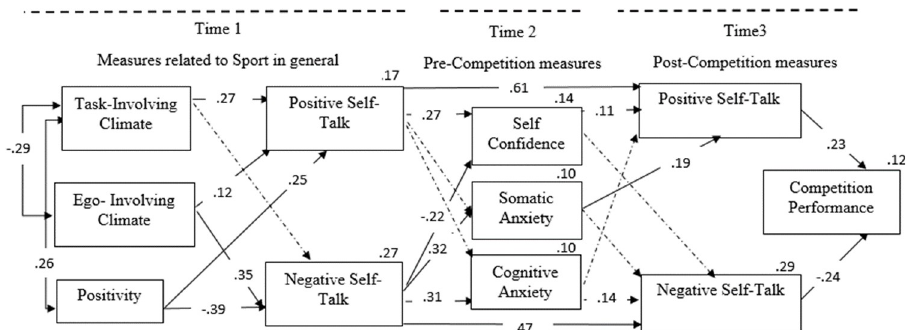
Fig 2. Final model with standardised parameter estimates. Significant paths are represented with solid lines and non-significant paths are shown with dotted lines.